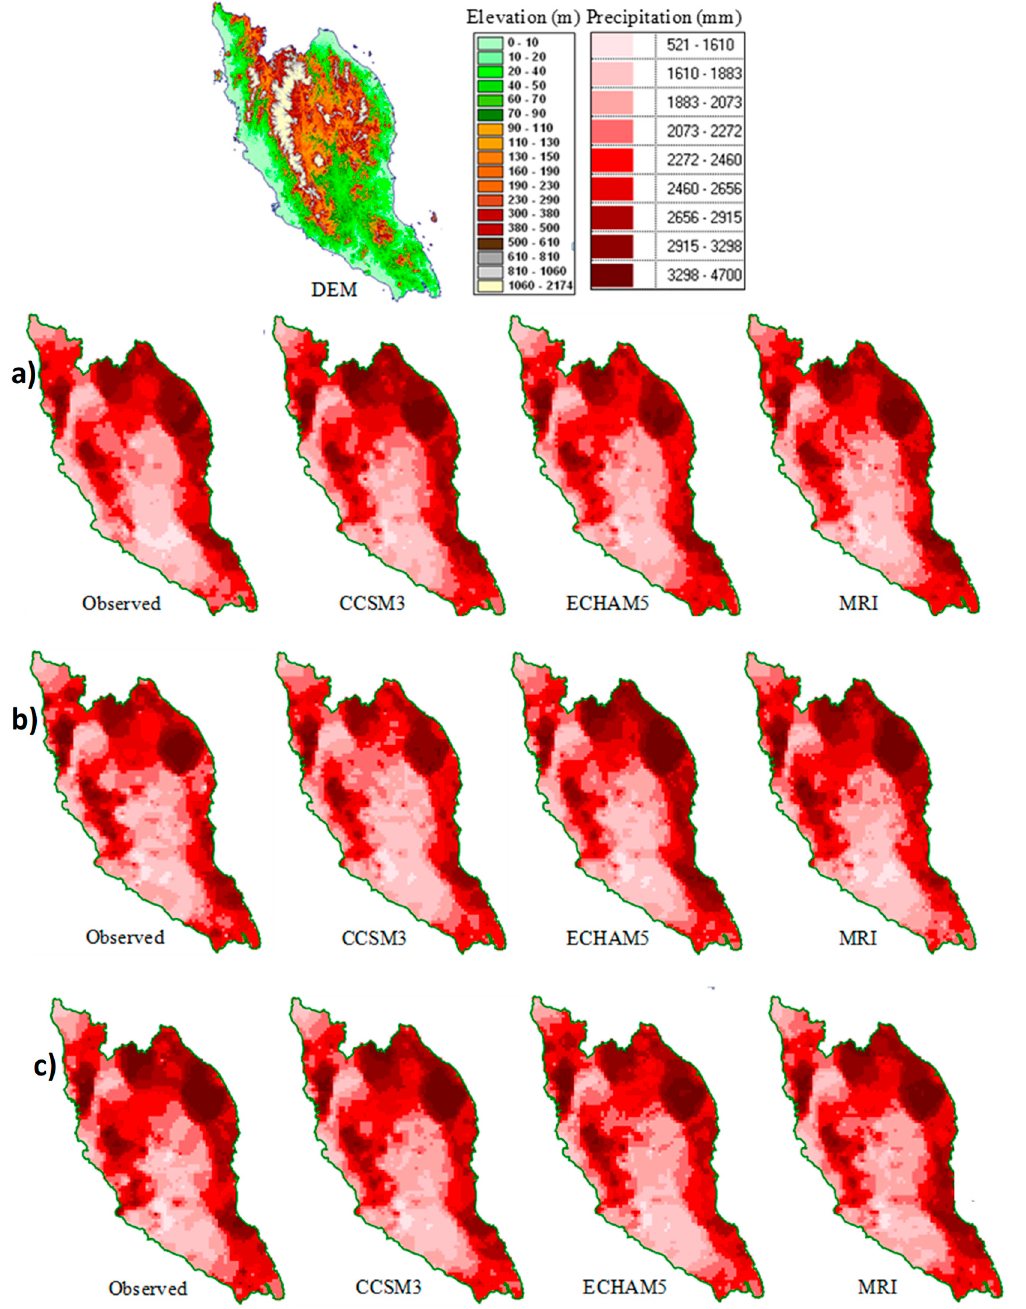
Figure 3. MM5-Simulated 10-year average annual precipitation during ( a ) 1970–1980, ( b ) 1980–1990, and ( c ) 1990–2000 by dynamically downscaling the control run data from CCSM3, ECHAM5 and MRI-CGCM2.3.2 global climate models, compared against observations.